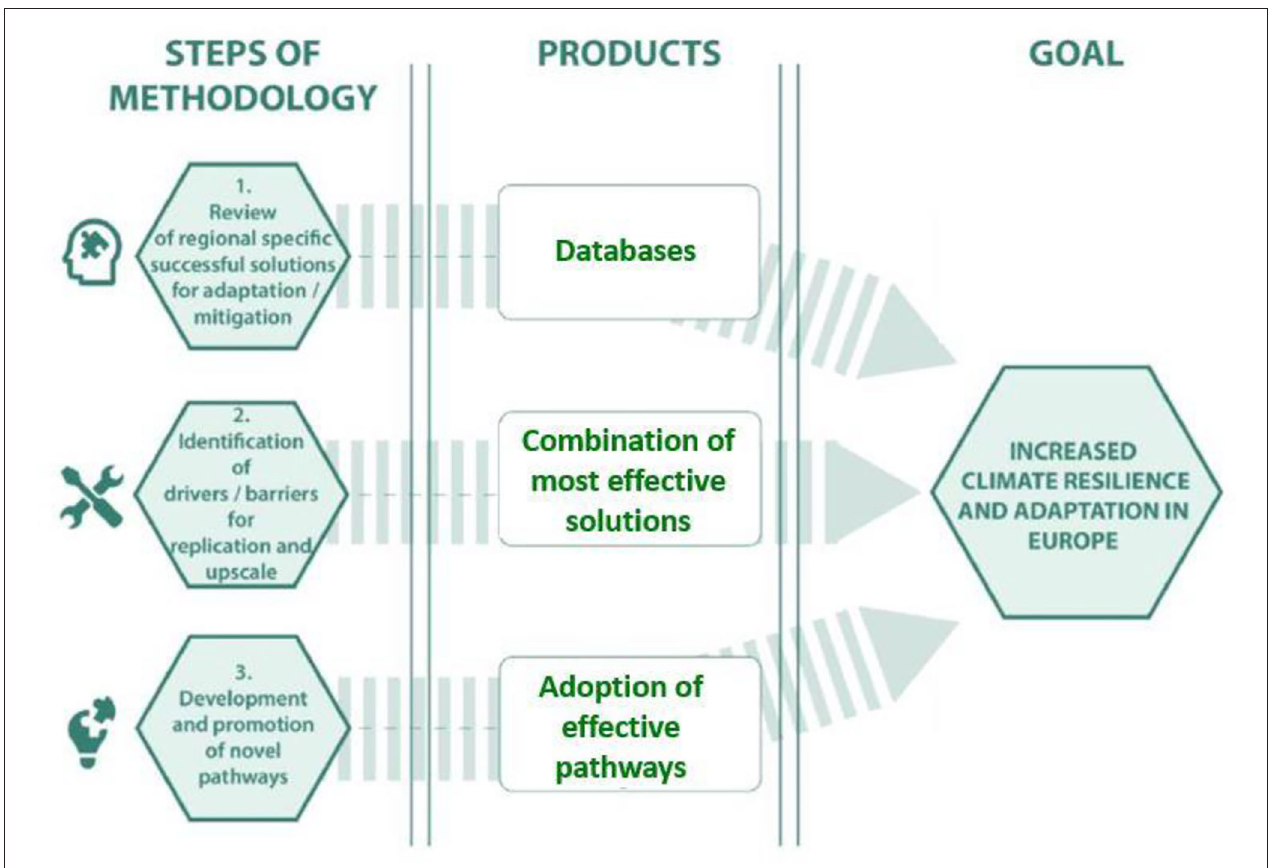
FIGURE 5 | Framework’s